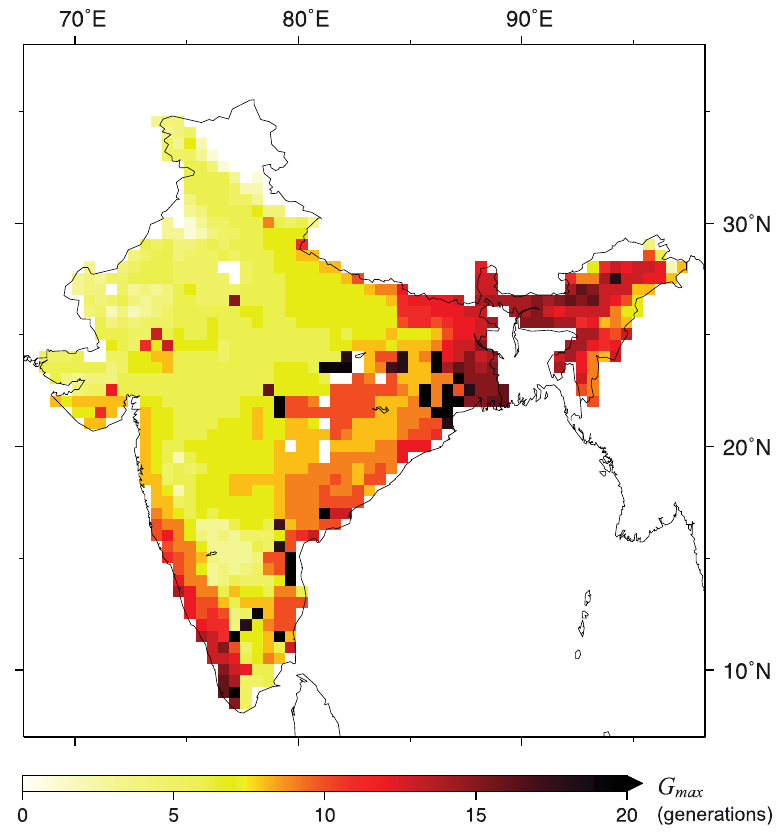
Figure 2. Geographical distribution of the maximum number of Anopheles generations ( G ) produced max